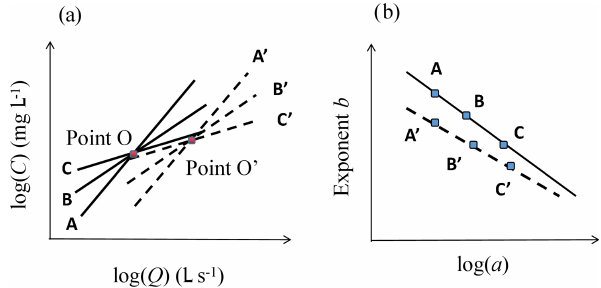
Figure 2. Schematic showing (a) how sediment rating curves (SRCs) may rotate around a common point and (b) how exponents b of the SRCs relate to coefficients a . Lines A, B, and C on the left are SRCs of different periods (e.g., years) sharing a similar common point O. Once sediment regimes shift due to changes in catchment characteristics (change in drainage density, drainage area, and to- pography), the common point O changes to point O’, and the linear relationship between a and b of the SRCs also exhibits a shift. The schematic is based on log C = log a + b · log Q (Eq.